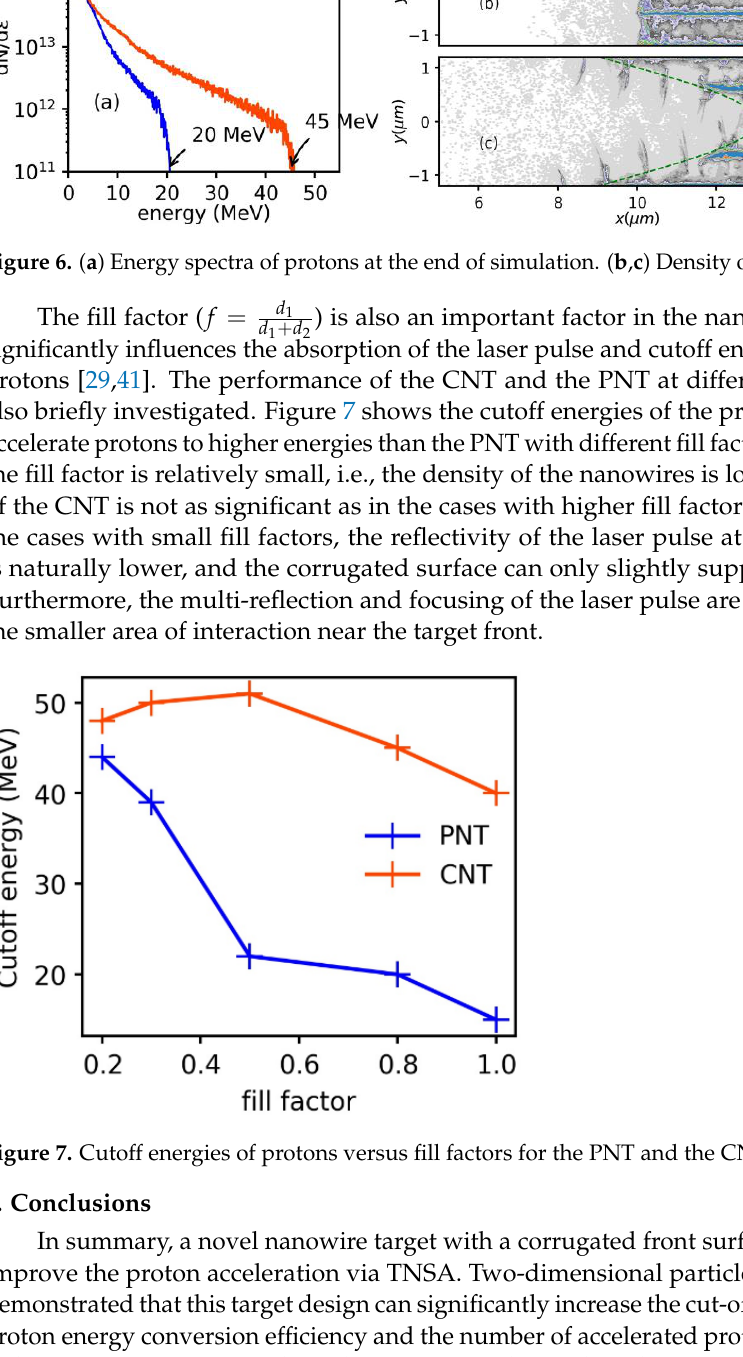
Figure 6. ( a ) Energy spectra of protons at the end of simulation. ( b , c ) Density of electrons at 𝑡 = 22𝑇 . 0